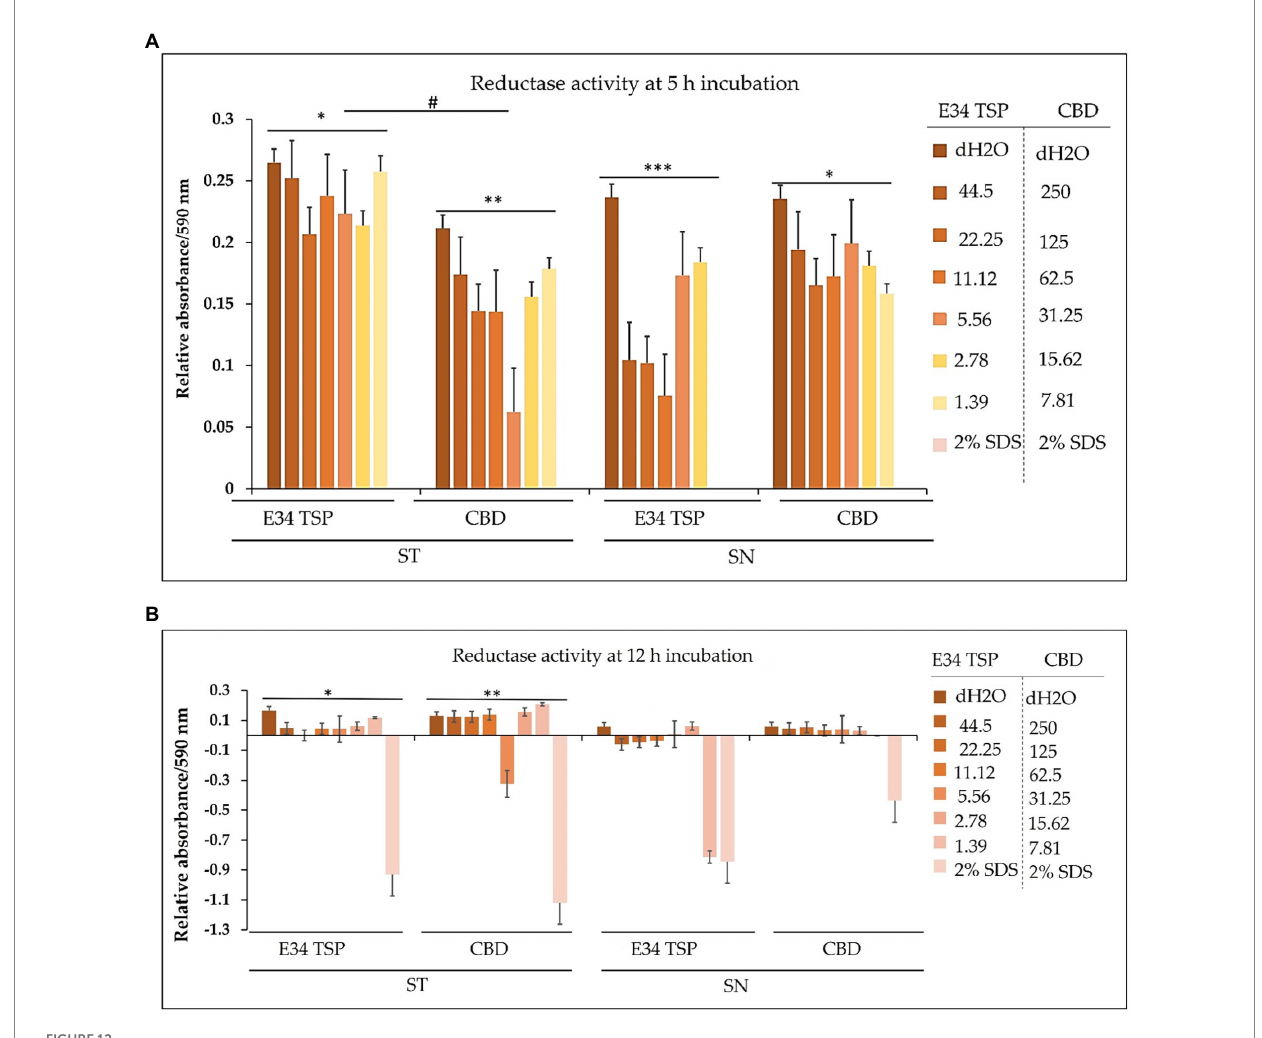
FIGURE 12 (A) Chart illustrating the S . Typhimurium and S . Newington dehydrogenase activity in 1 h after treatment to varying concentrations of CBD extract or E34 TSP. Data shown are from three independent experiments expressed as means ± SEM. * and ** value of p s ≤ 0.0000024, *** and ****value of p s ≤ 0.0032, # p -value = 0.0038. (B) Chart illustrating the S . Typhimurium and S . Newington dehydrogenase activities in 5 h after treatment to varying concentrations of CBD extract, or E34 TSP. Data shown are from three independent experiments expressed as means ± SEM. * and ** p - values ≤